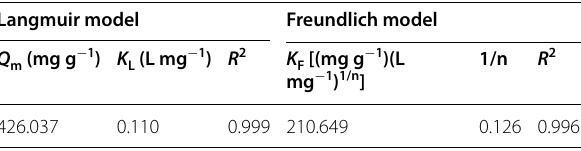
Table 6 Langmuir and Freundlich isotherm of CR on PCMCA- 900 Langmuir model